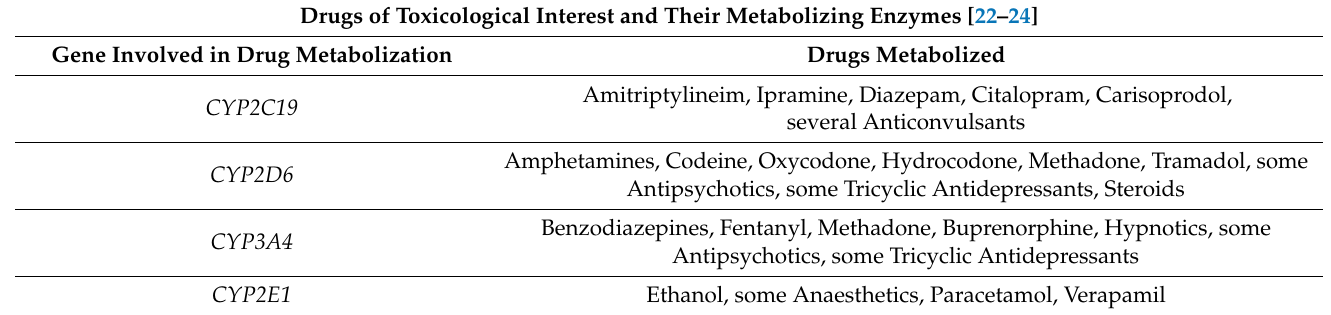
Table 1. Main enzymes involved in drug metabolism in forensic toxicology. Drugs of Toxicological Interest and Their Metabolizing Enzymes